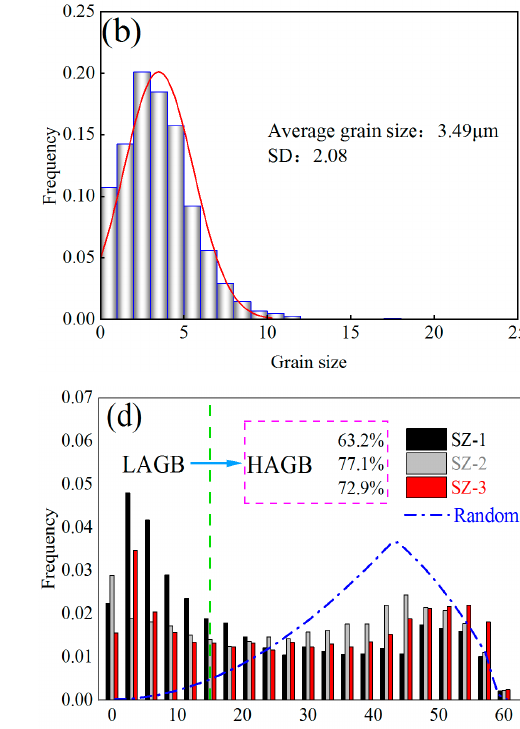
Figure 4. Grain morphology maps of SZ ( a ) SZ-1; ( b ) SZ-2; ( c ) SZ-3 and ( d ) BM.